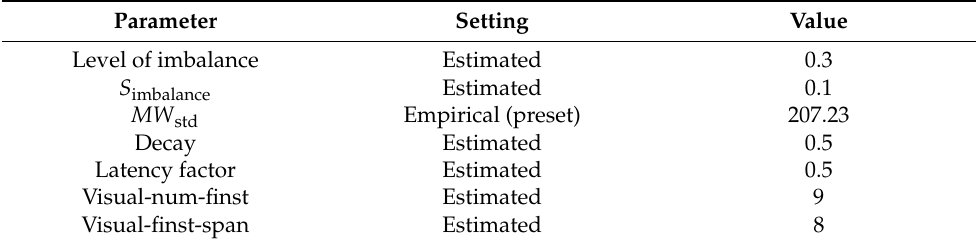
Table 2. Parameter setting values of the model in the